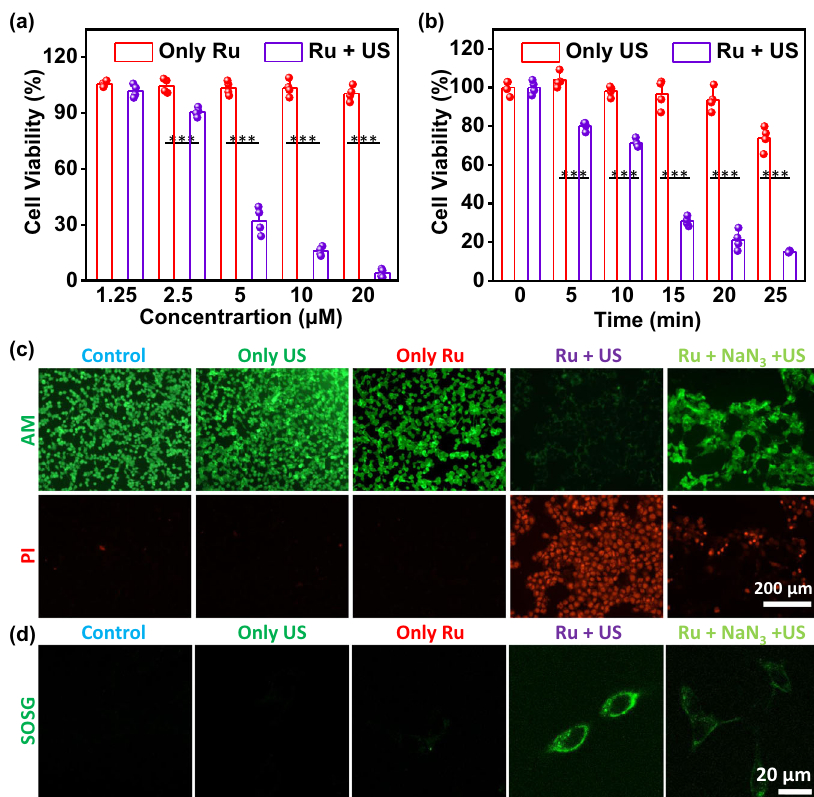
Fig. 3 In vitro sonotherapy ef fi ciency. a The cell viabilities of 4T1 cells after incubation with different concentrations of [Ru(bpy) 3 ] 2 + in the presence or absence of US. b The cell viabilities of 4T1 cells treated with [Ru(bpy) 3 ] 2 + (10 μ M) for varied US irradiation time. c Confocal images of 4T1 cells stained with calcein AM (green, live cells) and propidium iodide (red, dead cells) after different treatments. The experiment was repeated three times independently with similar results. d Confocal images of 4T1 cells stained with SOSG (green) after various treatments. Ru: [Ru(bpy) 3 ] 2 + ; US: 0.3 W cm − 2 , 3 MHz, 20 min; AM: calcein AM; PI: propidium iodide. All cell viability data was performed as duplicates of quadruplicate ( n = 4 biologically independent samples). Error bars represent S.D. from the mean. Statistical signi fi cance was calculated with two-tailed Student ’ s t test ( a ) and ( b ) (*** p < 0.001, ** p < 0.01, or * p <